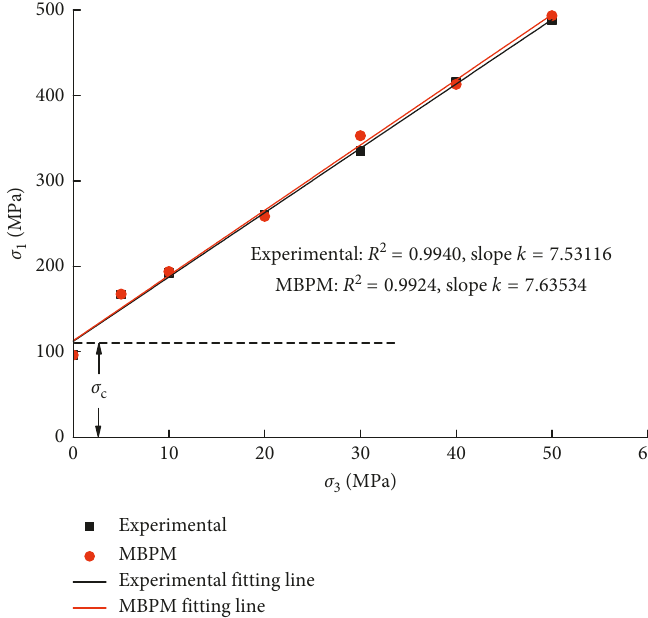
Figure 20: Mohr–Coulomb strength envelopes from experimental results and numerical